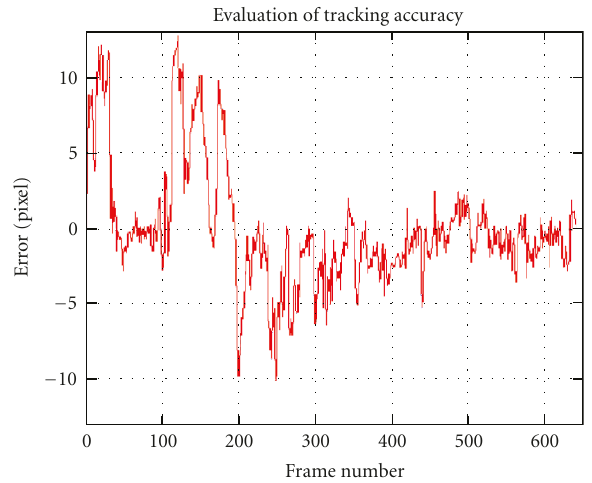
Figure 18: Tracking error after normalization using the scales. The horizontal axis is the frame index, and the vertical axis is the track- ing error in pixels after normalization with the